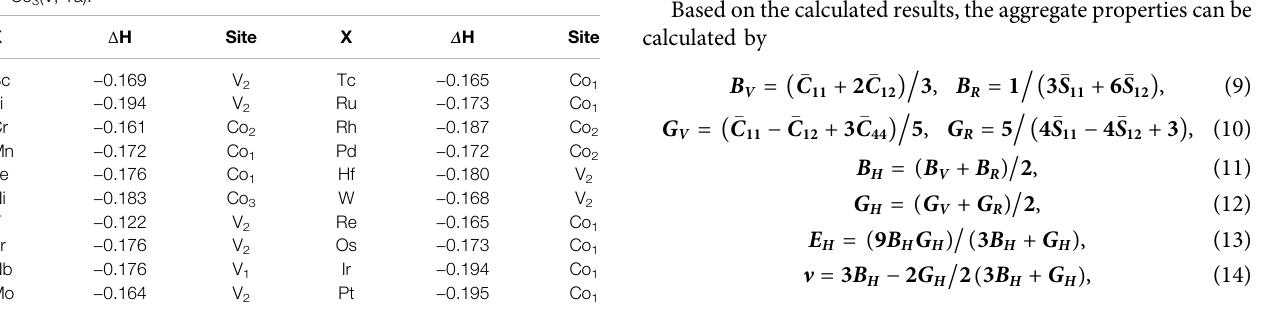
TABLE1| Sitepreferenceandformationenthalpies Δ H(eV/atom)ofX-substituted γ ′ -Co 3 (V,